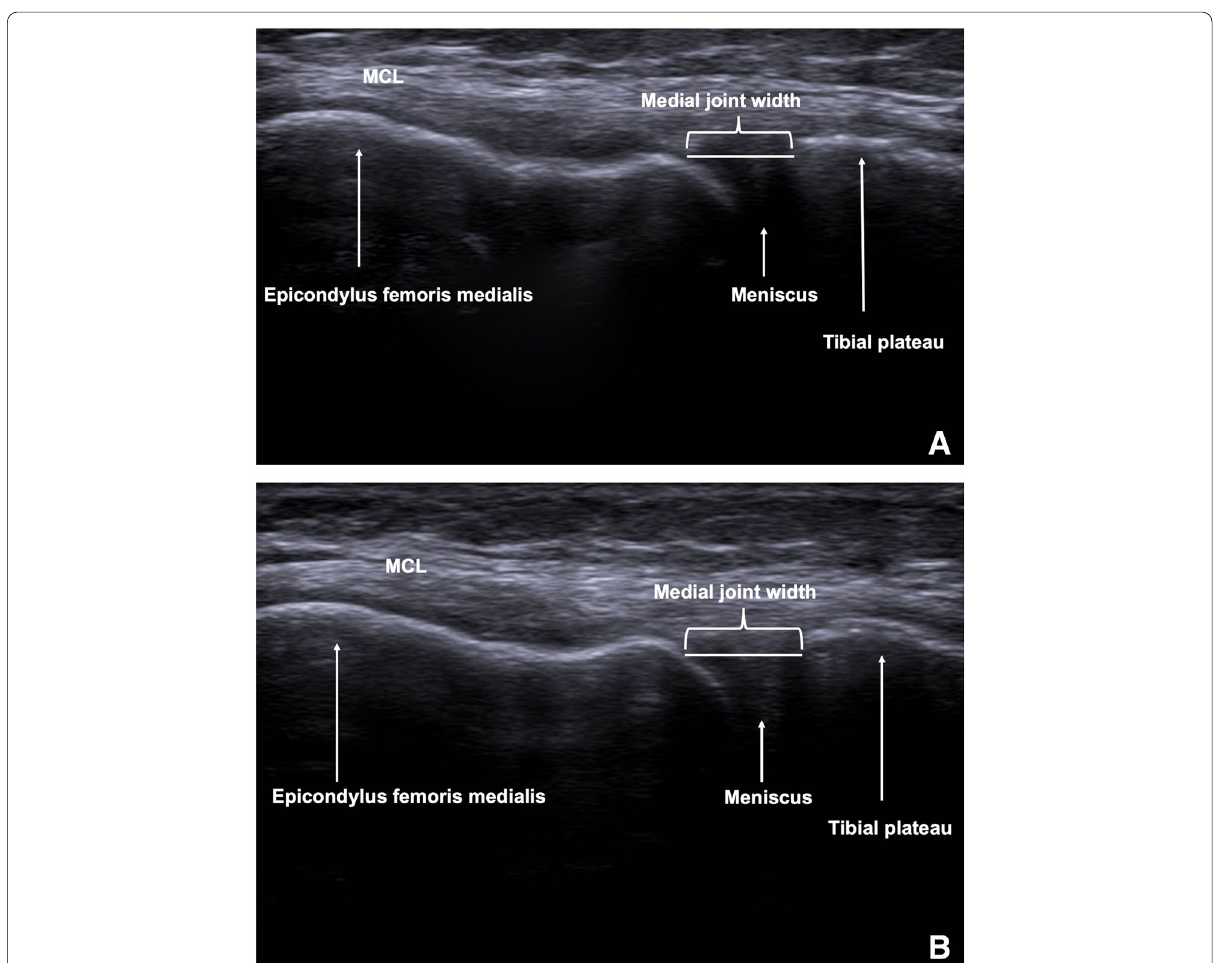
Fig. 1 Ultrasound image of the medial joint space width in 30° knee flexion in unloaded condition ( 1A ) and in standardized loaded condition (15 daN) with TELOS fixation device ( 1B ). White arrows show medial femoral epicondyle, medial meniscus, and tibial plateau. A white line is positioned between femoral and tibial margins where medial joint width can be measured in millimeters. MCL, medial collateral